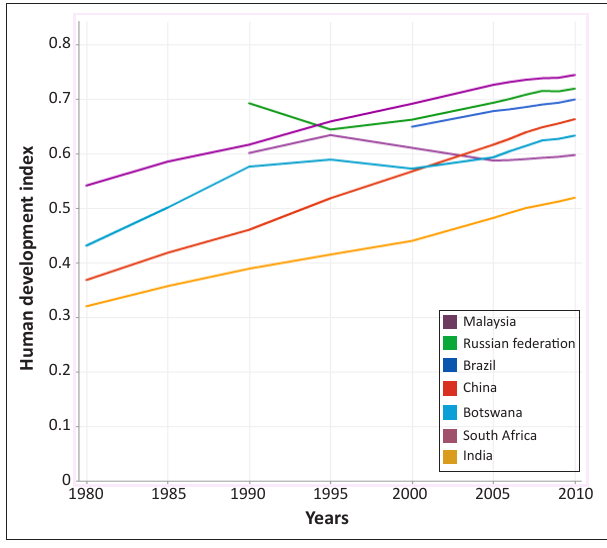
FIGURE 2: Human development index